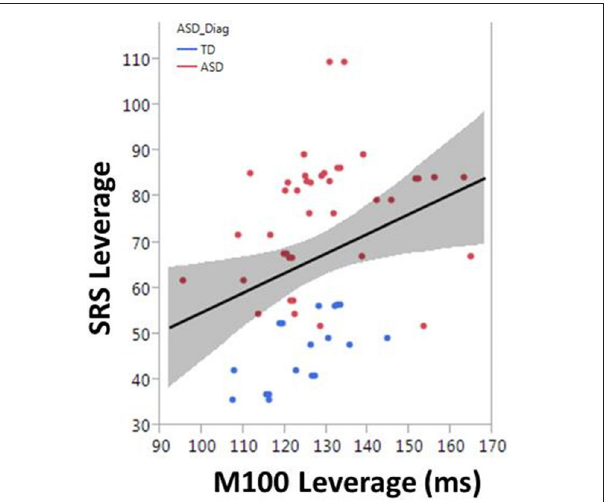
FIGURE 5 | The correlation between M100 and SRS is observed in the partial regression leverage plot. The ordinate (y-axis) of the leverage plot shows the residuals of the response variable (SRS) when regressed on all model parameters except M100. The abscissa (x-axis) of the leverage plot shows the residuals from regressing M100 against the other independent variables. M100 is a significant predictor of SRS ( p = 0.02 ).